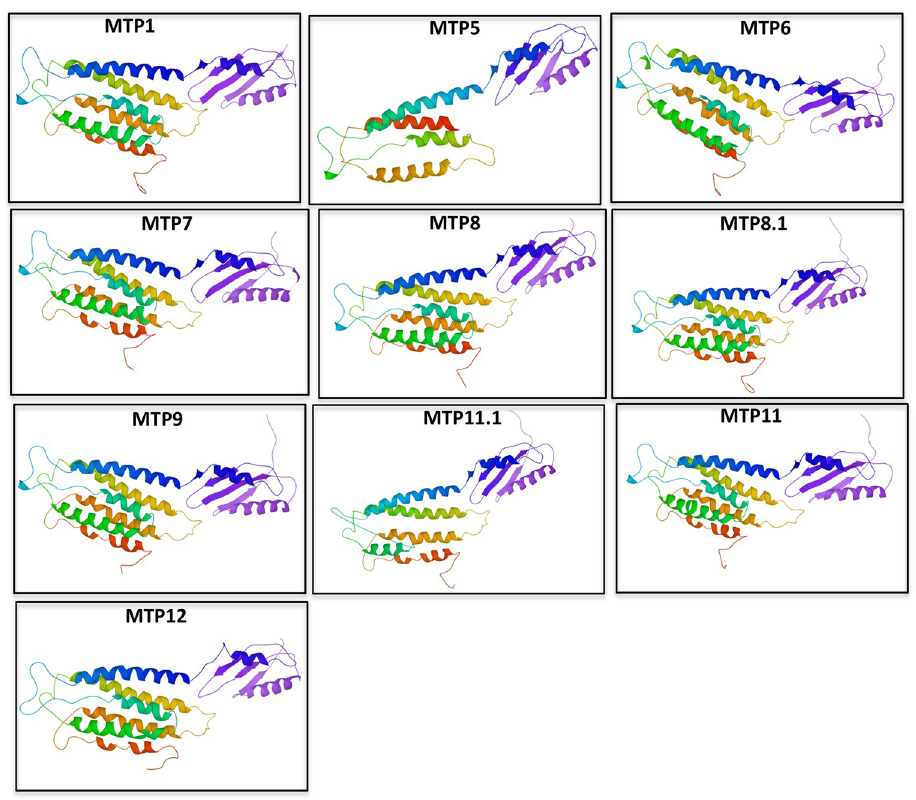
Fig 2. Predicted 3D models of rice MTP proteins. Models were generated by using Phyre2 protein-modeling server at intensive mode. The protein 3D structures were further refined using ModRefiner.